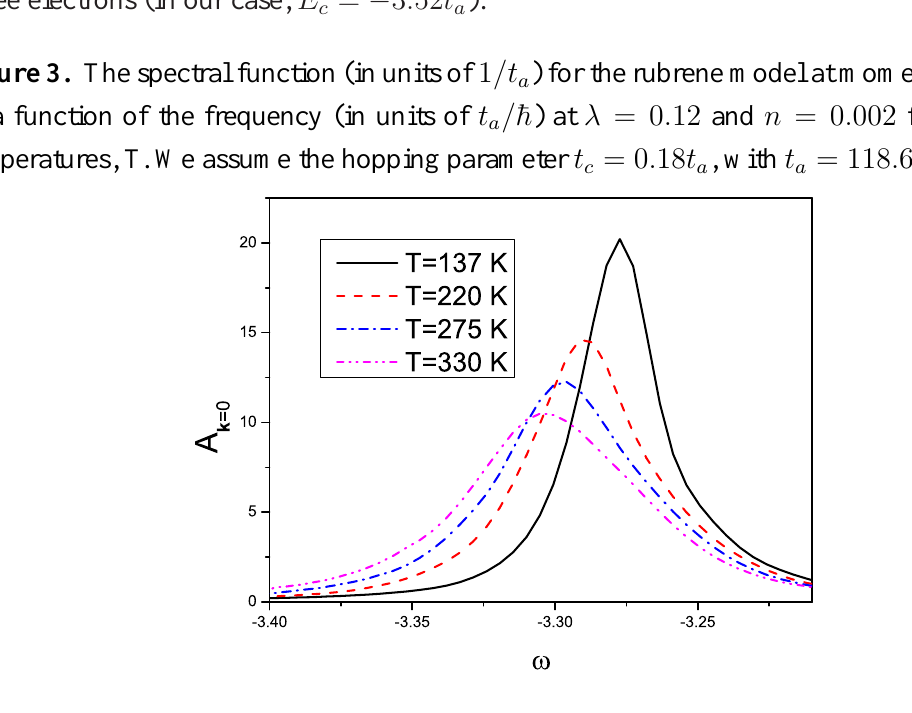
Figure 4. The density of states (DOS) (in units of 1 /t ) for the rubrene model as a function a of the frequency (in units of t / ¯ h ) at λ = 0 . 12 and n = 0 . 002 for different temperatures, T. a The squares indicate the chemical potential, µ (in units of t ) at fixed temperature. E p a line, in units of t ) is the free electron band edge close to the mobility edge. We assume the a hopping parameter t , with t = 0 . 18 t = 118 . 6 c a a